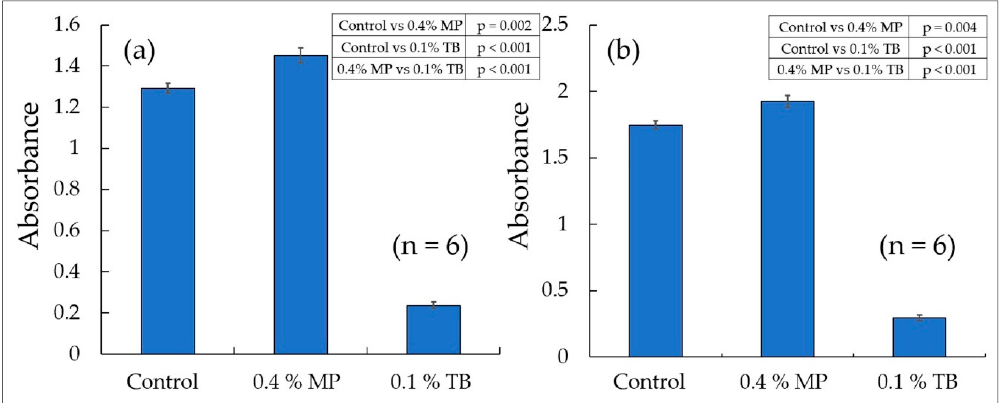
Figure 6. Cytotoxicity assay (WST-8). ( a ) 24 h; ( b ) 48 h